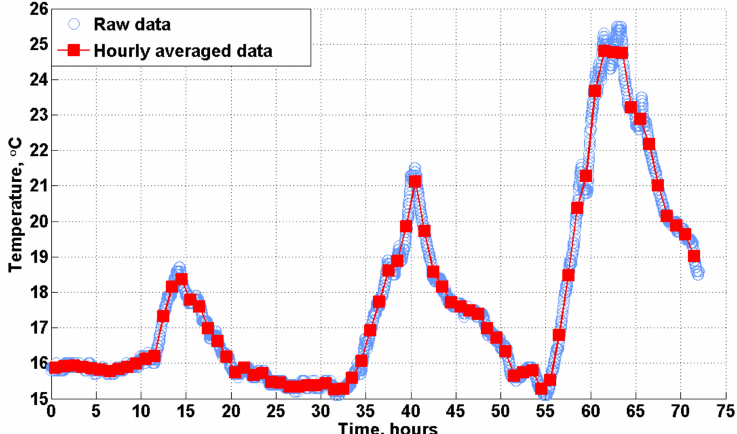
Figure 9. Examples of the hourly averaged